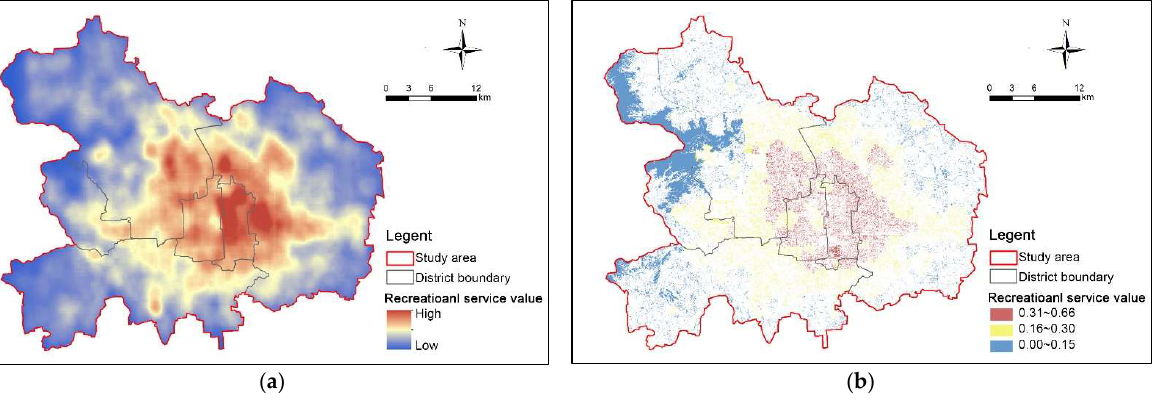
Figure 6. ( a ) Spatial distribution of overall recreational services in the study area; ( b ) spatial distribution of urban forest recreational services. Table 6. The distribution of the levels of recreational services.